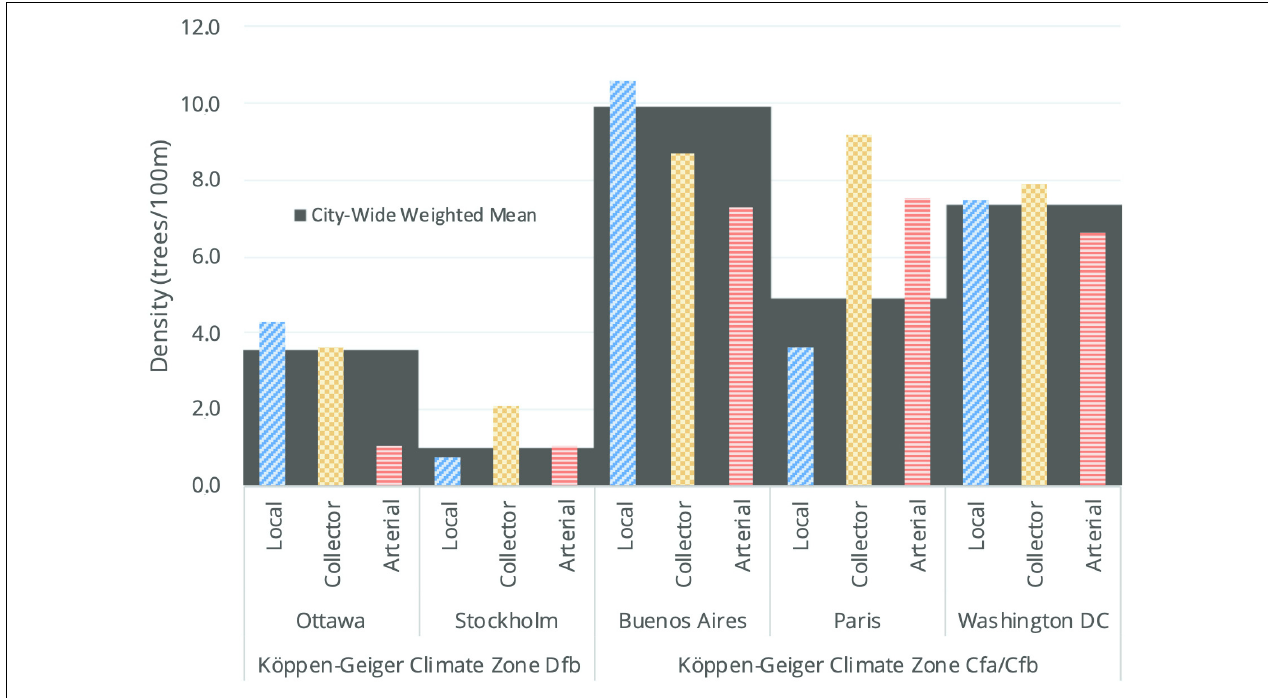
FIGURE 3 | Weighted mean street tree density by street class, city, and climate zone.